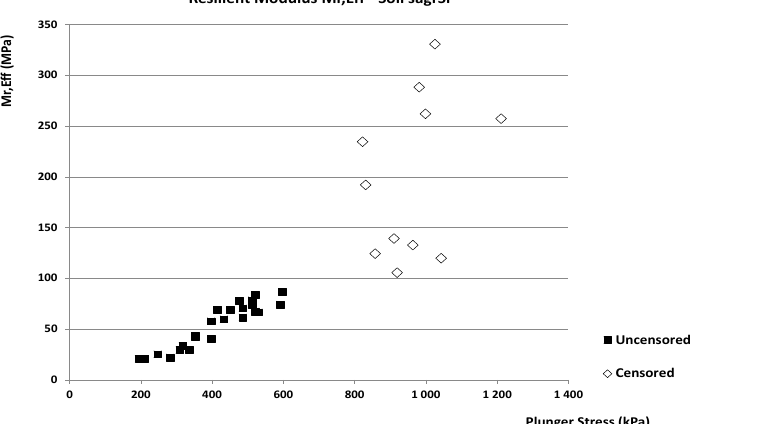
r,eff for soil sagrSi.